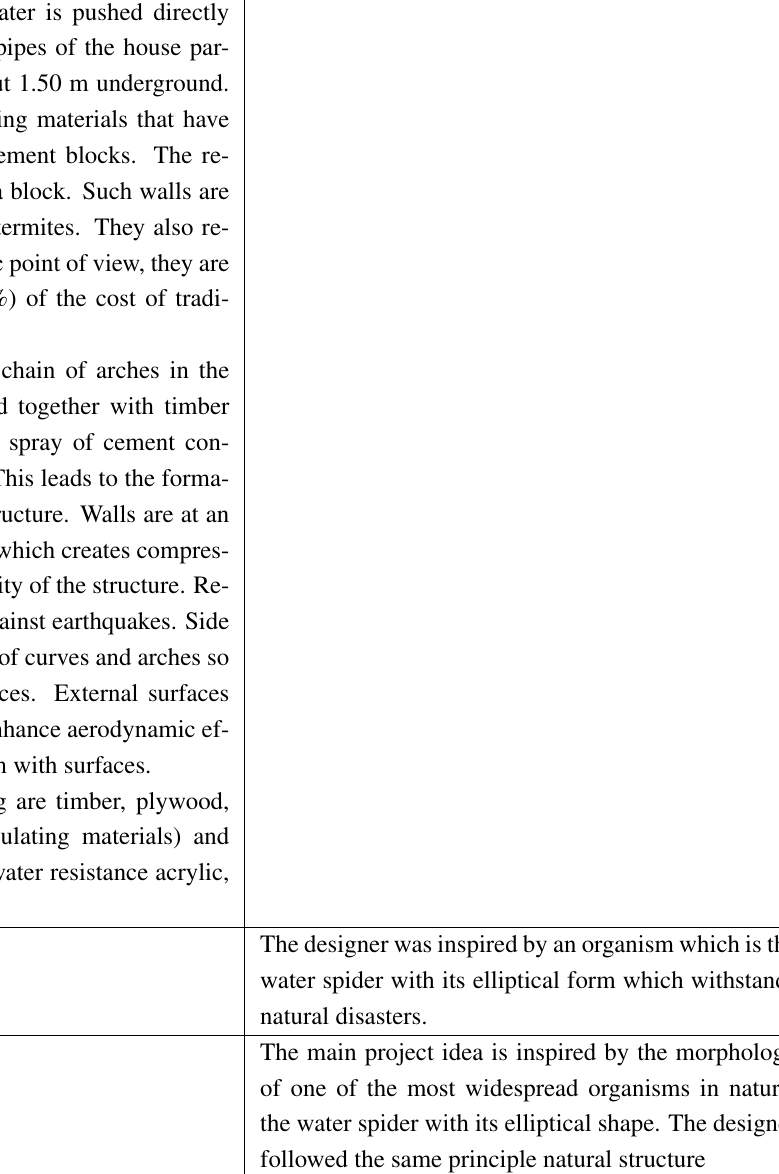
Figure 9, Figure 10, Figure 11, Figure 12 Tilted walls towards the inside with a 4 ◦ angle forming structural compression toward center of gravity also generated side forces help to resist earthquakes